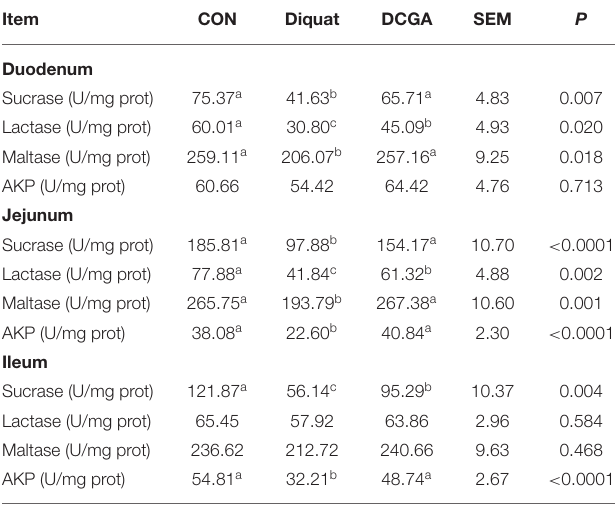
TABLE 3 | Effects of CGA on intestinal enzyme activities in weaned pigs upon oxidative stress 1